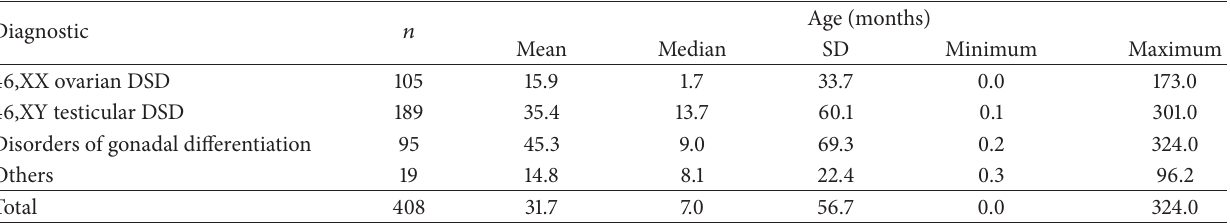
Table 3: Variation of the age at the first visit for 408 consecutive cases of DSD with ambiguous genitalia followed at GIEDDS, UNICAMP, between January 1989 and December